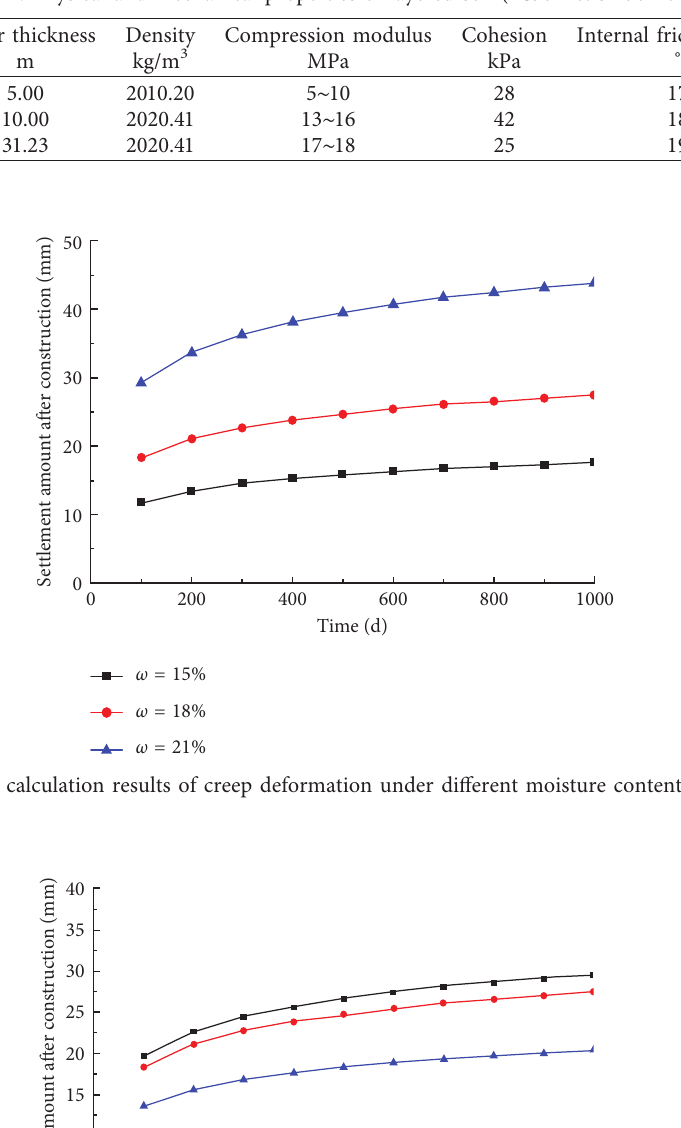
Table 12: Physical and mechanical properties of layered soil (TS95+670– 95+770).